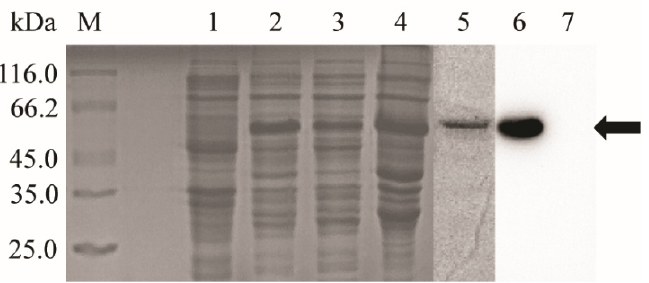
Figure 1. Identification of protein expression and purification of rOn-CD80/86 by SDS-PAGE (lane 1-5) and western blot (lanes 6 and 7). The black arrow refers to rOn-CD80/86. Lane M: marker; lane 1: E. coli with pGEX-4T-CD80/86 without IPTG induction; lane 2: E. coli with IPTG induction; lane 3: E. coli soluble protein with IPTG induction; lane 4: E. coli inclusion body protein with IPTG induc- tion; lane 5: purified rOn-CD80/86; lane 6: experiment group (use mouse anti-his IgG); lane 7: control group (use mouse IgG).